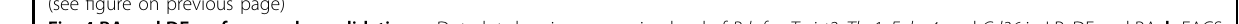
Fig. 4 BA and DF surface marker validation. a Dot plot showing expression level of Pdgfra , Twist2 , Thy1 , Fabp4, and Cd36 in LP, DF and BA. b FACS plot of YFP + cells from E9.5 Pax7-traced mouse embryos on E12.5, E13.5, E14.5, E15.5, and E16.5. Cells were stained with Thy1 and Pdgfra antibodies to validate the presence of surface markers. X -axis indicates the signal from Thy1 antibody while y -axis indicates the signal from Pdgfra antibody. c FACS plot of YFP + cells from E14.5 and E16.5 that were stained with Thy1 and Cd36 antibodies. X -axis indicates signal from Thy1 antibody while y- axis indicates signal from Cd36 antibody. d Correlation plot of bulk and pseudobulk samples. After FACS sorting with the following surface marker combination: Pdgfra + /Thy1 + , Pdgfra + /Thy1 − , and Pdgfra − /Cd36 + , samples were either prepared for sequencing immediately or cultured. Each row represents one bulk sample. Rows annotated with the same color indicate replicates within the same condition. Gene expression was Z-score normalized. e Volcano plots of differentially expressed genes between sorted samples. Genes with adjusted P -value < 0.01 were colored by corresponding cluster color (log-fold change > 1.5 or < − 1.5), whereas ≥ 0.01 were colored as gray. Lineage markers and surface markers were labeled adjacent to corresponding